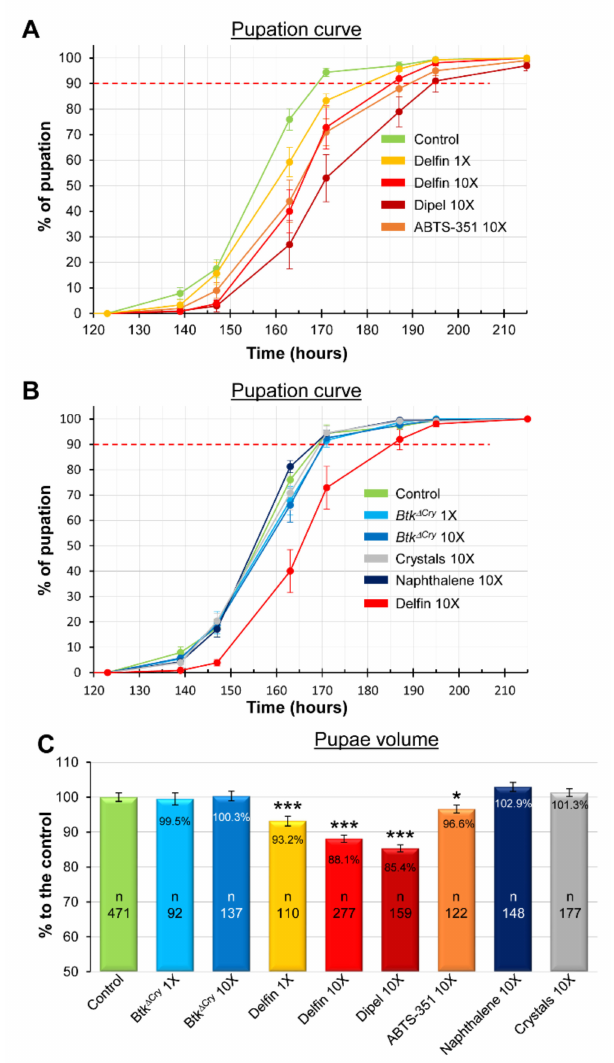
Figure 1. Btk bioinsecticide impacts on developmental delay and growth defects. ( A ) Pupation curve of larvae fed with commercial products (Delfin and Dipel) or with a homemade preparation of spores of the Btk strain ABTS-351 (Dipel). 152 < n < 262. In this figure and in all the following figures, the cumulative percentage of pupation is shown over time. ( B ) Pupation curve of larvae fed with a Btk strain devoid of Cry toxins ( Btk ∆ Cry ) or with Cry toxin containing crystals purified from Dipel or with naphthalene sulfonic acid at a concentration equivalent to the amount found in Delfin 10X. In ( A , B ), red dashed lines mark 90% of the population reaching pupation. 143 < n < 263. ( C ) Pupae volume in the di ff erent conditions listed on the x-axis. n = number of individuals counted. For the controls, n corresponds to the total number of pupae measured when one compiled all the internal controls. Error bars represent the standard error of the mean (SEM). * p < 0.05; *** p < 0.001 compared with